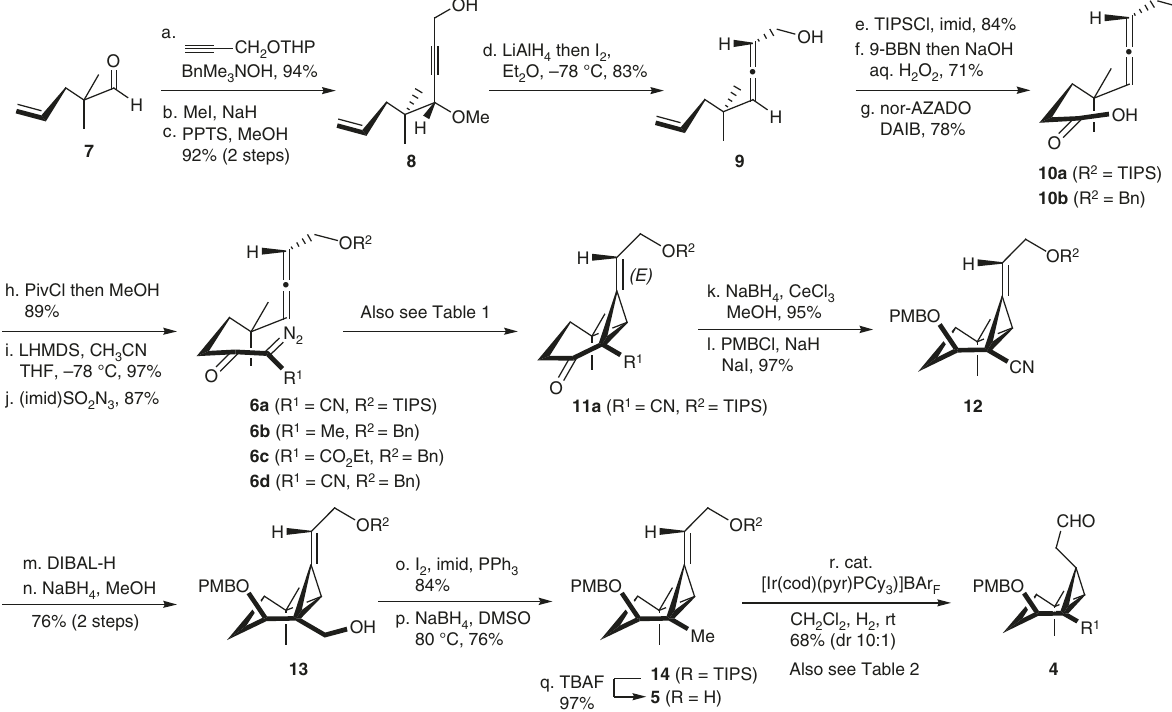
Fig. 3 Synthesis of all- cis -substituted cyclopropane 4 . Conditions: a HC ≡ CCH 2 OTHP, BnMe 3 NOH, DMSO, 94%; b NaH, MeI, THF – DMPU; c pyridinium p -toluenesulfonate, MeOH, 92% (two steps); d LiAlH − 78 °C, 83%; e TIPSCl, imidazole, DMF, 84%; f 9-BBN, then aq. NaOH, aq. H 4 then I 2 , Et 2 O, 2 O 2 , 71%; g nor-AZADO, DAIB, CH 2 Cl 2 – pH 7 buffer, 78%; h PivCl, i Pr 2 NEt, then MeOH, DMAP, 89%; i lithium bis(trimethylsilyl)amide, CH 3 CN, THF, − 78 °C, 97%; j (imidazoyl)SO 2 N 3 , pyridine, CH 3 CN, 87%; k NaBH 4 , CeCl 3 , MeOH 95%, (dr 17:1); l PMBCl, NaH, NaI, THF, 0 – 50 °C, 97%; m diisobutylaluminium hydride, toluene – THF, − 78 °C to rt; n NaBH 4 , MeOH, 0 °C, 76% (two steps); o I 2 , PPh 3 , imidazole, CH 2 Cl 2 , 0 °C; 84%, p NaBH 4 , DMSO, 80 °C, 76%; q TBAF, THF, 97%; r [Ir(cod)(pyr)PCy 3 ]BAr F , CH 2 Cl 2 , H 2 , 68% (dr 10:1). THP tetrahydropyranyl, DMPU N , N ′ -dimethylpropylene urea, triisopropylsilyl,